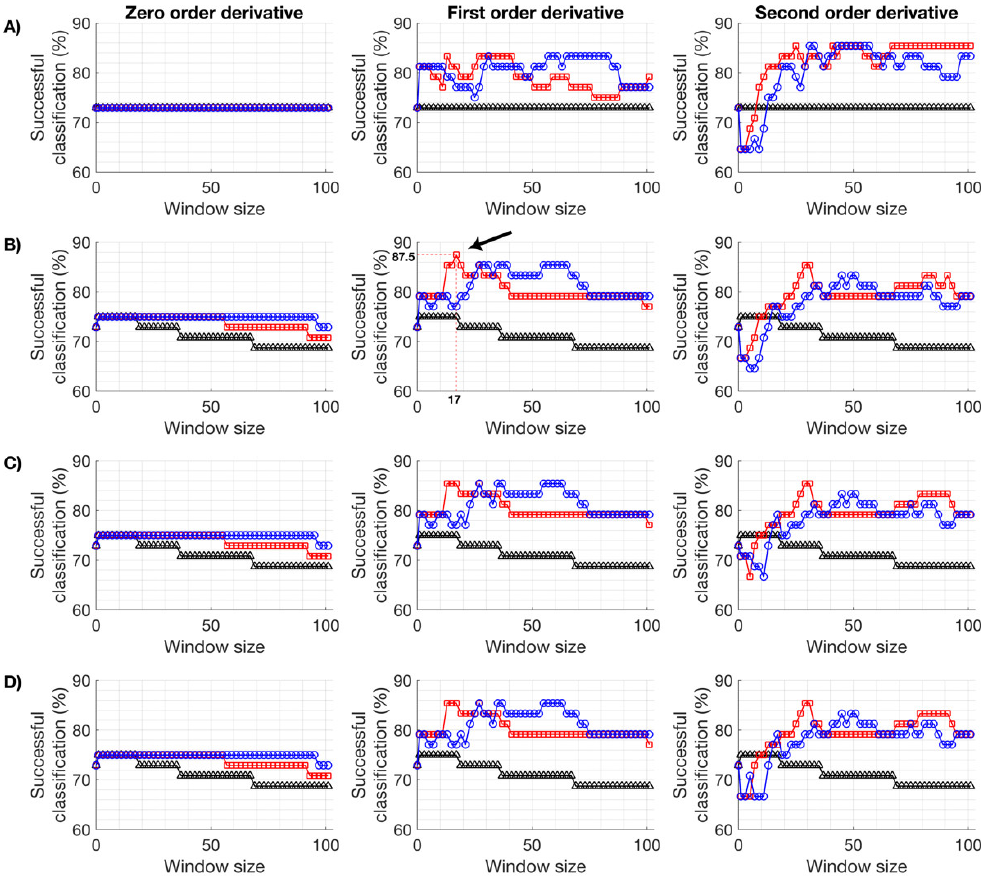
Figure 1. E ff ect of Savitzky–Golay (SG) and Loopy Multiplicative Scatter Correction (LMSC) parameters on the performance of Partial Least Squares Discriminant Analysis (PLS-DA) predictive models. For SG filtering, each derivative order (columns) was queried across a constant (black triangle), quadratic (red square), and quartic (blue circle) order polynomial, and each of these was then followed by zero, one, two, and three iterations of LMSC (rows A – D , respectively). The highest successful classification (%) of all combinations of SG and LMSC parameters was highlighted (arrow).